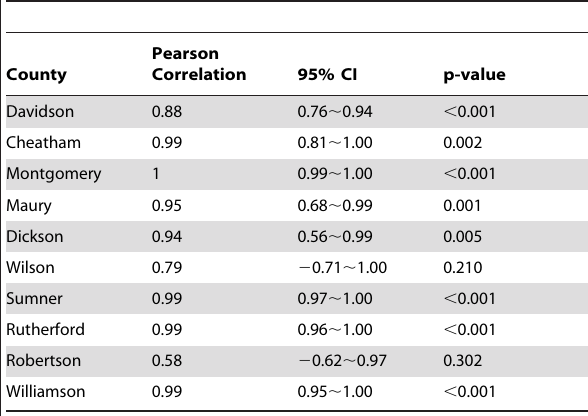
Table 4. Correlation between incidence rate and post- menopausal proportion in Middle Tennessee